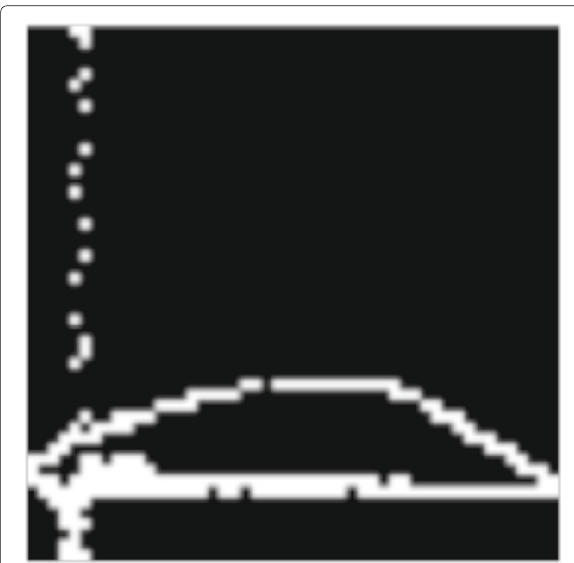
Fig. 7 An example of an image I obtained from a portrait G